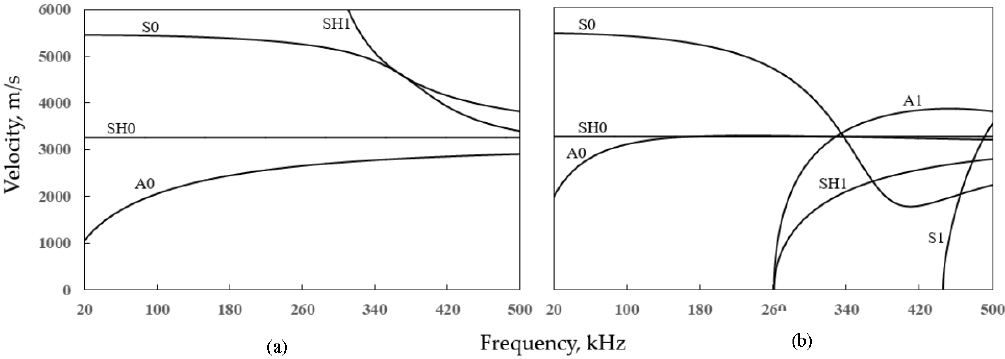
Figure 1. Dispersion curves for a 6.25 mm thick steel plate ( a ) phase velocity and ( b ) energy velocity.